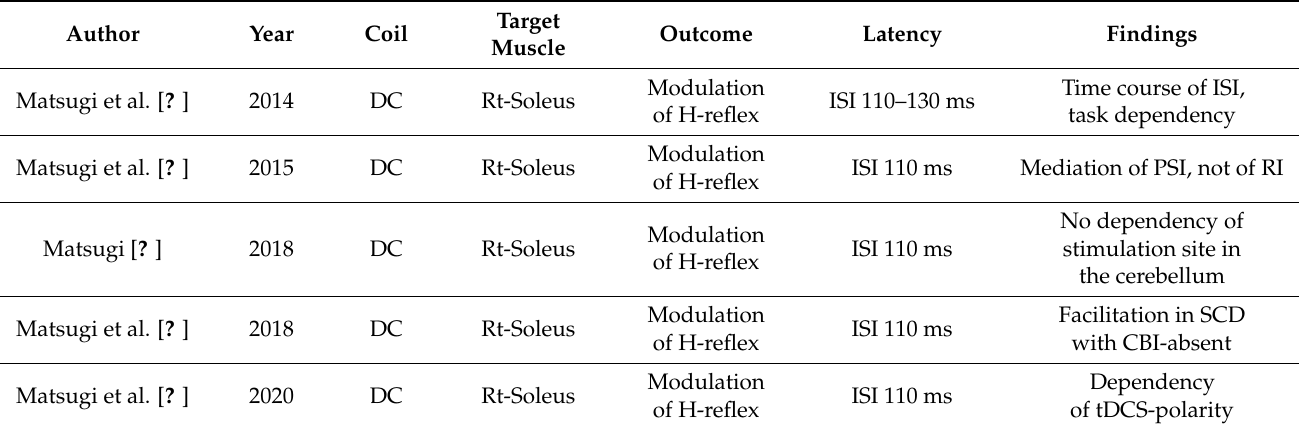
Table 2. Studies of single pulse cerebellar TMS and spinal